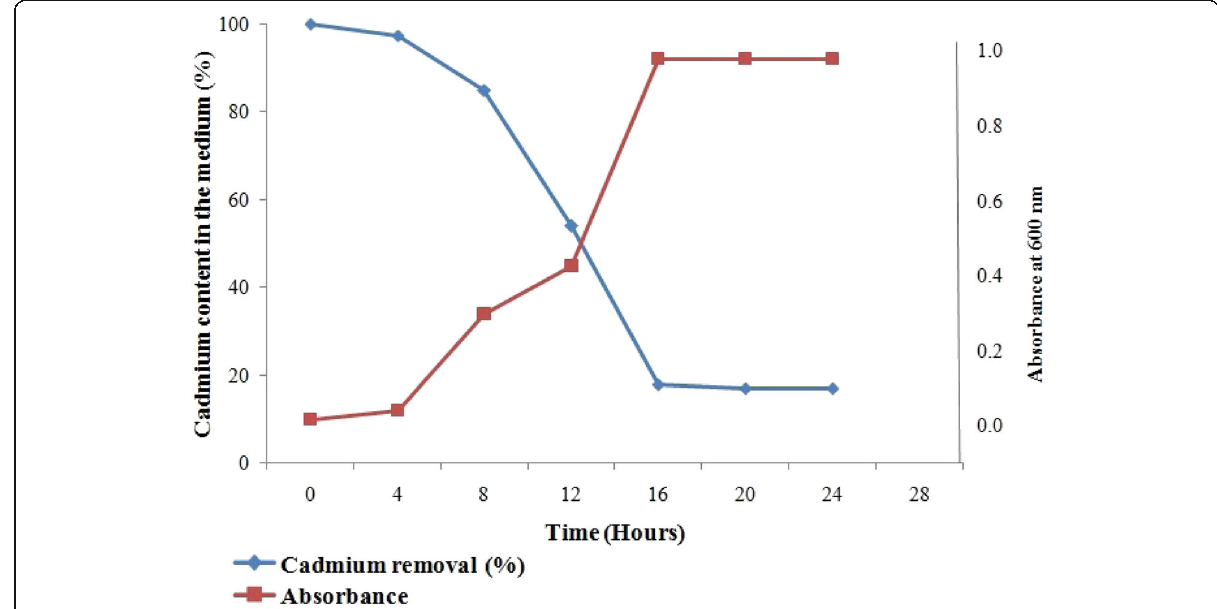
Fig. 7 Removal of cadmium by Pseudomonas resinovorans